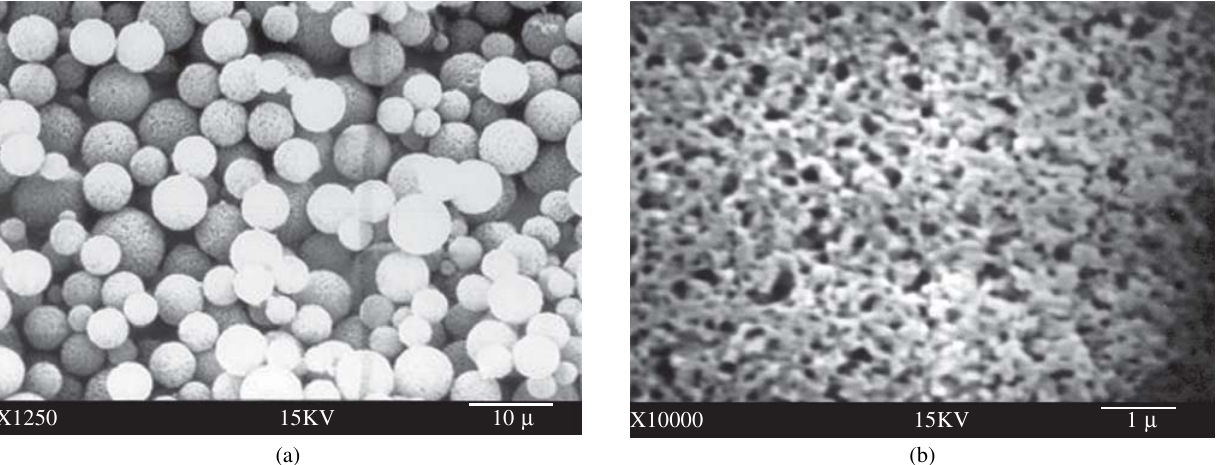
Figure 1. SEM micrograph of copolymerized HPMA/EDMA (1:1) beads with 41.25% addition of porogen solvent, DOD, before simple extraction (a, 1.250 ×, scale bar 10 µ m) and after Soxhlet extraction (b, 10.000 ×, scale bar 1 µ m).